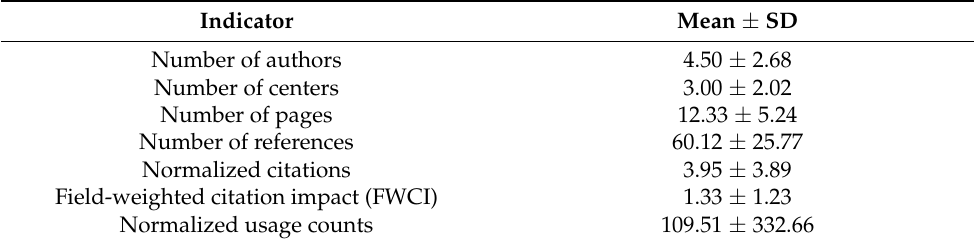
Table 1. Statistics of some article-related bibliometric indicators.